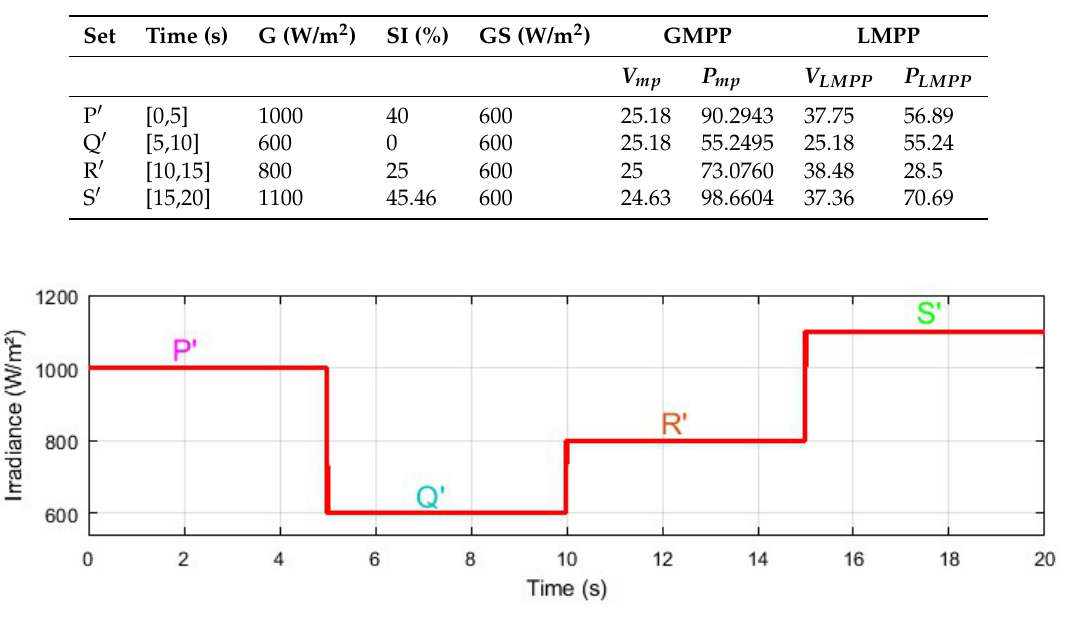
Table 9. Global MPP (GMPP) and local MPP (LMPP) for photovoltaic (PV)generator under different sets of partial shading at 25 ◦ C.